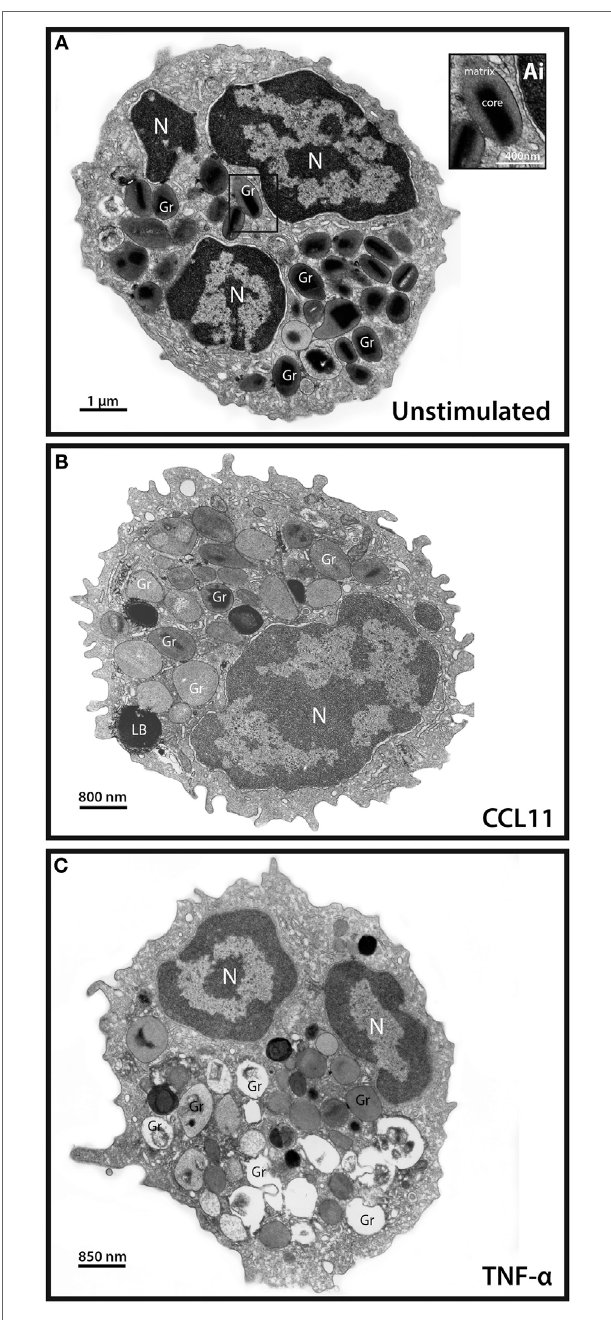
FigUre 1 | Conventional transmission electron microscopy (TEM) of resting and activated human eosinophils. (a) A representative eosinophil shows its typical cytoplasmic population of specific granules (Gr) with a unique morphology—an internal well-defined electron-dense crystalline core and an outer electron-lucent matrix [seen at higher magnification in (Ai)]. (B,c) In response to stimulation of eosinophils, their secretory granules undergo structural changes indicative of degranulation. CCL11 (B) induces granule content release in the absence of granule fusions while tumor necrosis factor alpha (TNF- α ) (c) leads to fusions between secretory granules. Disarrangement of the crystalline cores is observed in stimulated (B,c) compared to unstimulated (a) cells. Note in (a,c) , the typical bilobed nucleus (N). Eosinophils were isolated by negative selection from healthy donors, stimulated or not with CCL11 or TNF- α for 1 h, immediately fixed and prepared for TEM.